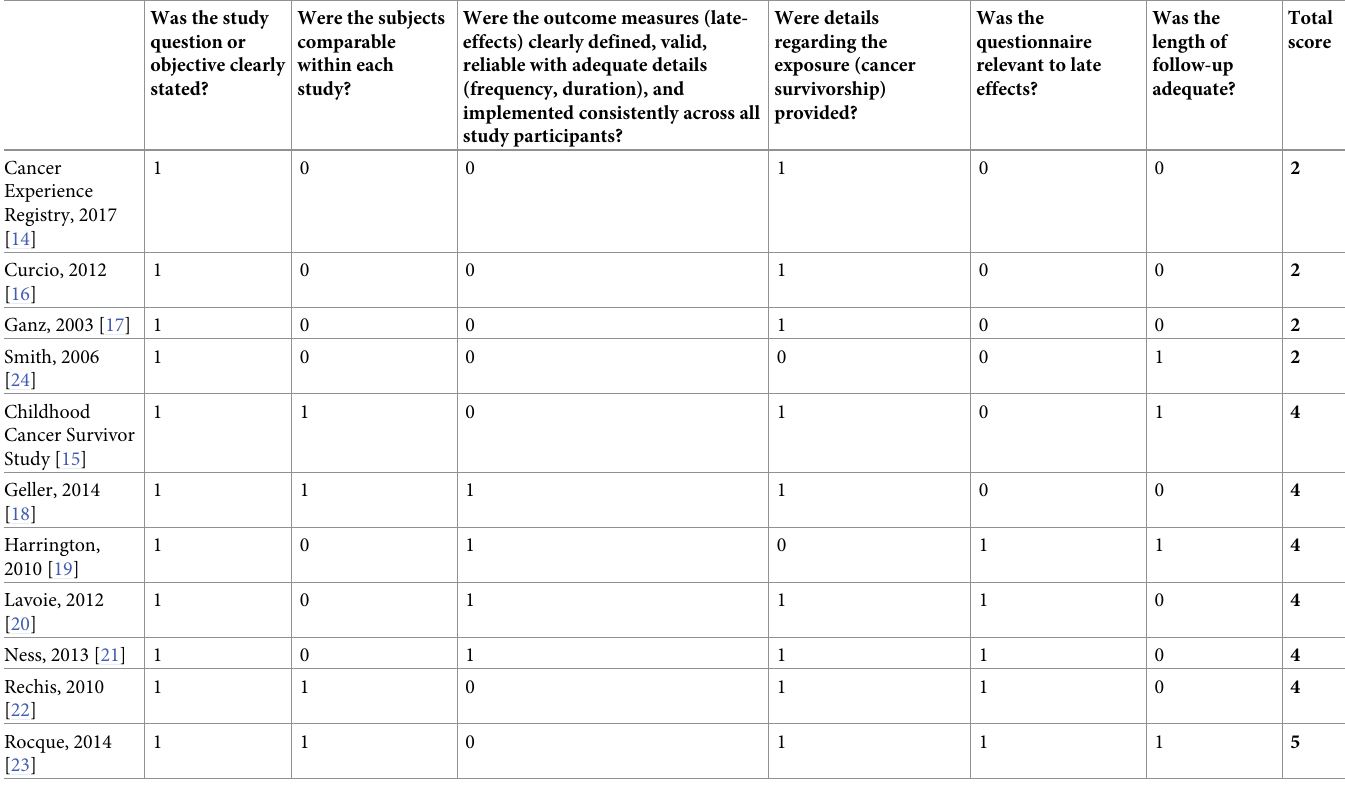
Table 2. Results of quality assessment of included